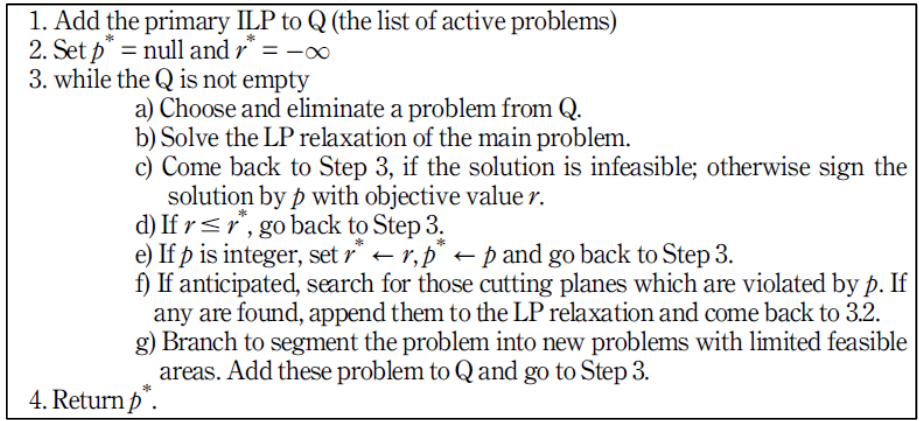
Figure 1. Pseudocode of a general B&C algorithm.